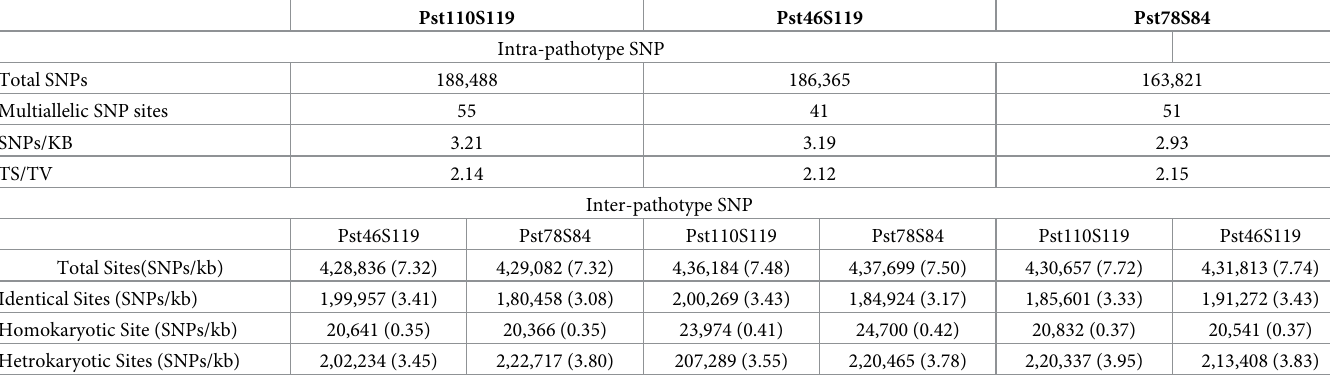
Table 3. Intra and inter-isolate single nucleotide variations among P . striiformis tritici pathotypes Pst110S119, Pst46S119 and